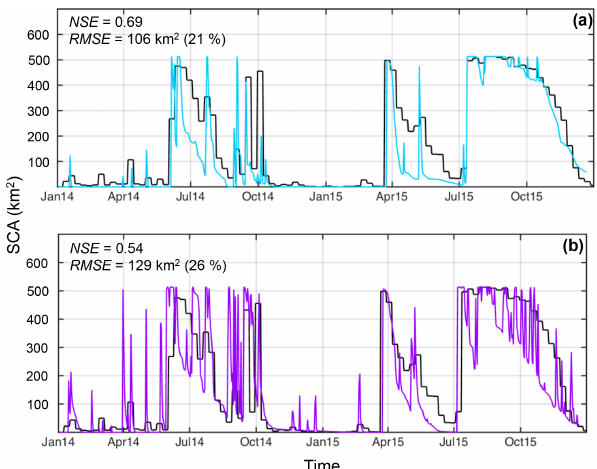
Figure 6. Snow cover area evolutions over the 2014–2015 period, from MODIS images (black lines), and simulations using (a) AWS forcing (blue line) and (b) WRF forcing (purple